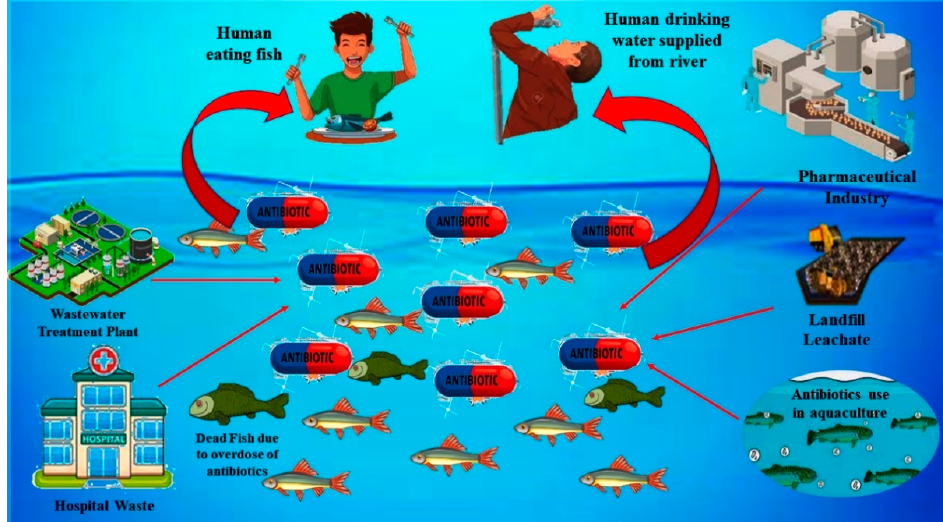
Figure 1. Graphical illustration of various point and non-point sources of SMX into the rivers and water resources.